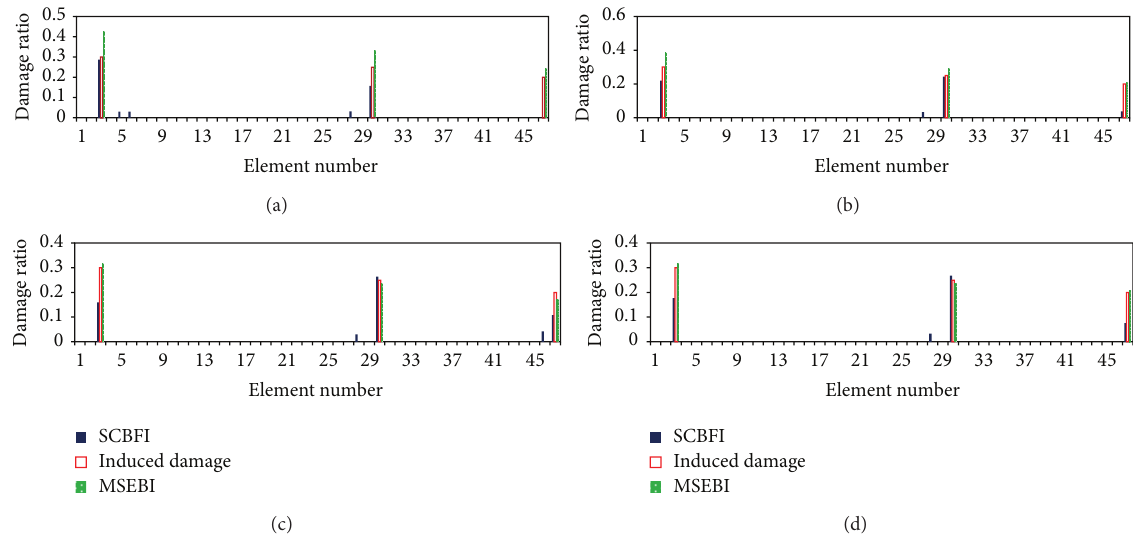
Figure 11: Comparison of damage index SCBFI with MSEBI for 47-bar planar truss for case 3 considering (a) 1 mode, (b) 2 modes, (c) 3 modes, and (d) 4 modes.